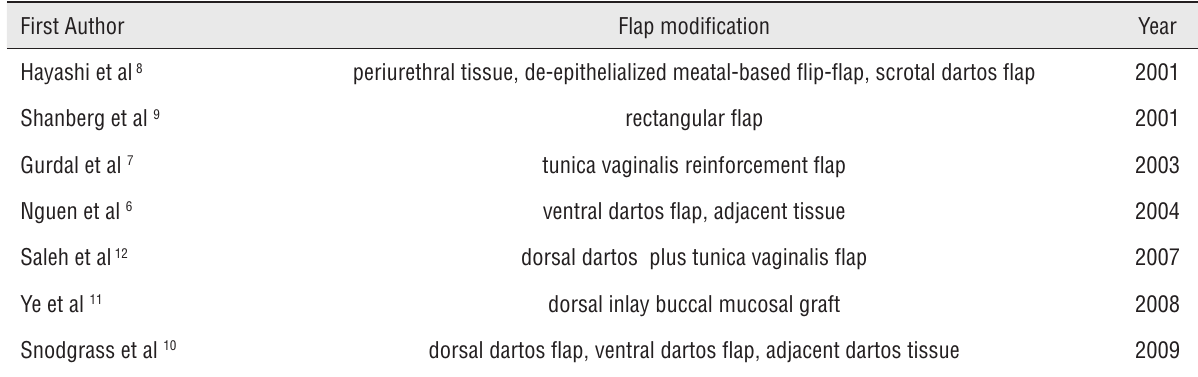
Table 2 - Technical modifications for the TIP procedure in patients with secondary (redo) hypospadias.